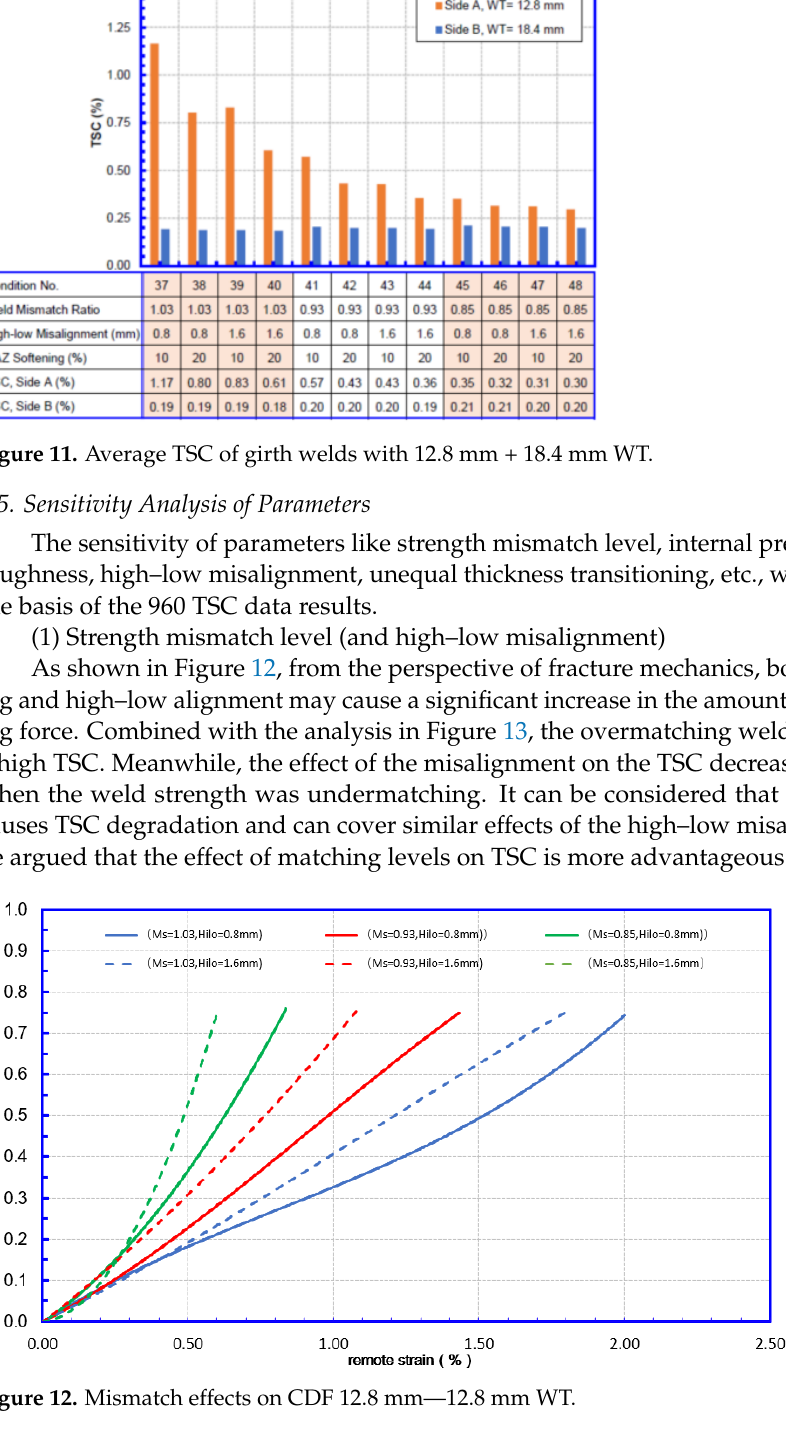
Figure 10. TSC of girth welds with 12.8 mm + 12.8 mm WT.